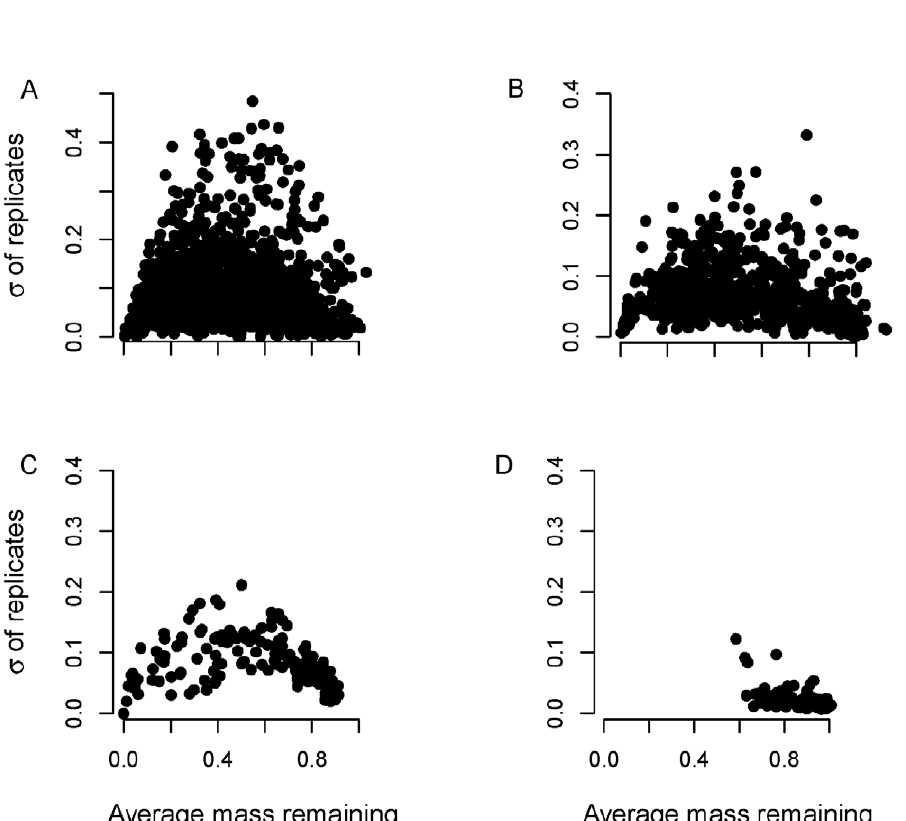
Figure 1. Figure of mean mass remaining versus standard deviation of replicates at each time point for real data. Mean mass remaining versus standard deviation of replicates at each time point for (A) Long-term Intersite Decomposition Experiment Team (LIDET) data, (B) Hobbie data; (C) EL data; and (D) HG data.